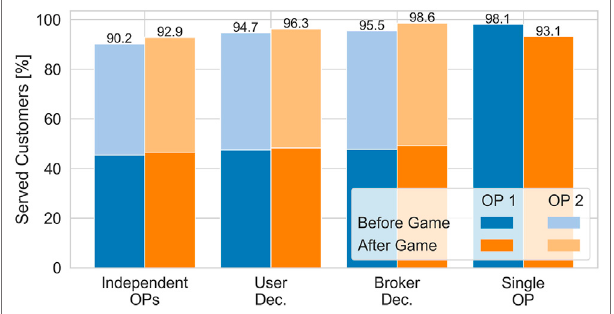
FIGURE 8 | Served Customers before and after the game for the different interaction scenarios.